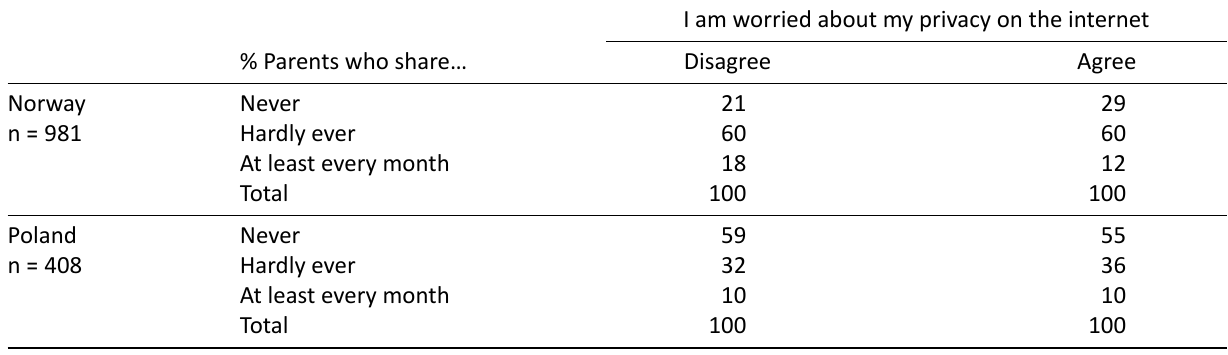
Table 4. How often do you share/post/blog photos/videos of your child online? By country and by whether or not parents are worried about their online